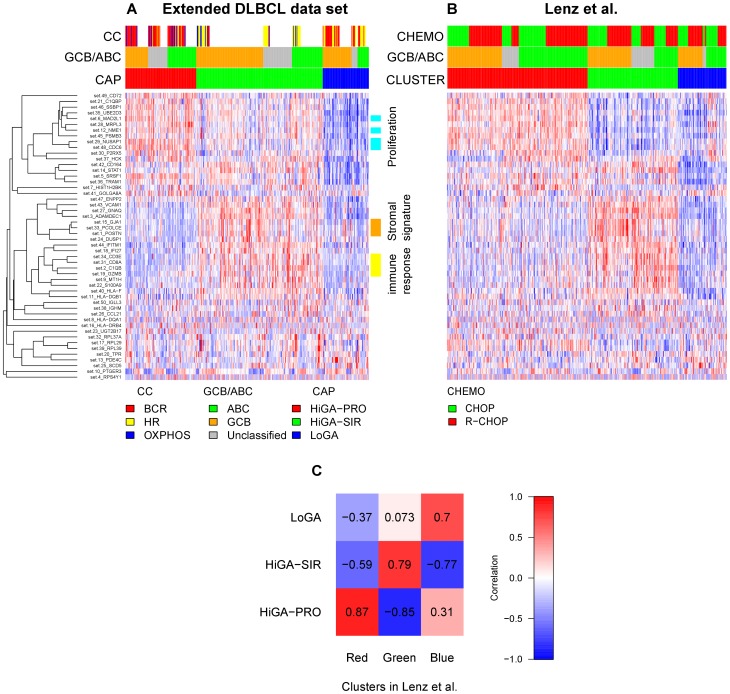
Unsupervised analysis with respect to the CGSs reveals three profiles across previously described molecular subtypes of DLBCL tumors. The three profiles are also detectable in an independent data set.A) Heat map of 50 CGSs generated in the extended DLBCL cohort (n = 364). Each row is a summary value of a CGS and each column corresponds to a sample. Red (blue) indicates a high (low) relative expression. Samples are grouped into HiGA-PRO (red), HiGA-SIR (green) and LoGA (blue). CGSs are hierarchically clustered using average linkage and one minus correlation as the distance measure. The color bars on the right indicate three groups of CGSs associated with proliferation, stroma and immune response, respectively. White spaces in the color bar “CC” are due to the fact that the classification into “consensus clusters” was available only for the 150 cases which overlapped with the BL/DLBCL data set of Hummel et al. (2006). B) Clustering (indicated by the color bar “CLUSTER”) of an independent data set of Lenz et al. (2008) (n = 414) with respect to the CGSs mapped from the extended DLBCL data set. The vertical order of the CGSs is the same as in Panel A. Within the clusters, the samples are sorted by their ABC/GCB/Unclassified subtype and by their treatment (CHOP, R-CHOP). C) Correlation matrix of the centroids of the CAPs and of the clusters generated in the data set of Lenz et al. (2008).